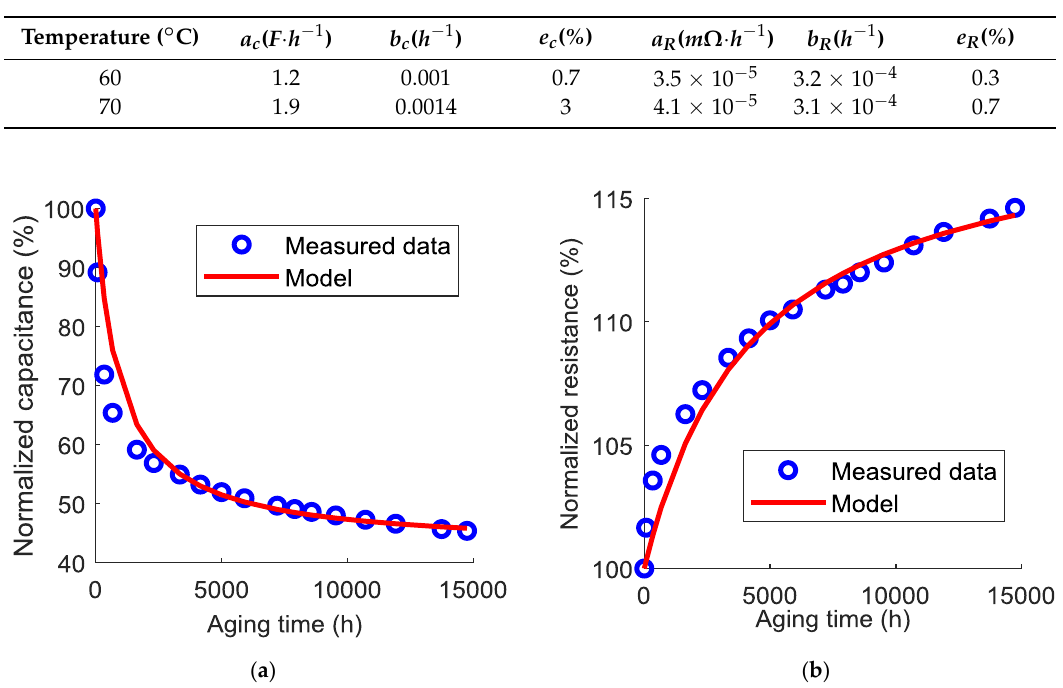
Figure 9. Comparison between the measured data and the models of the capacitance ( a ) and the equivalent series resistance ( b ) evolution at 70 °C.